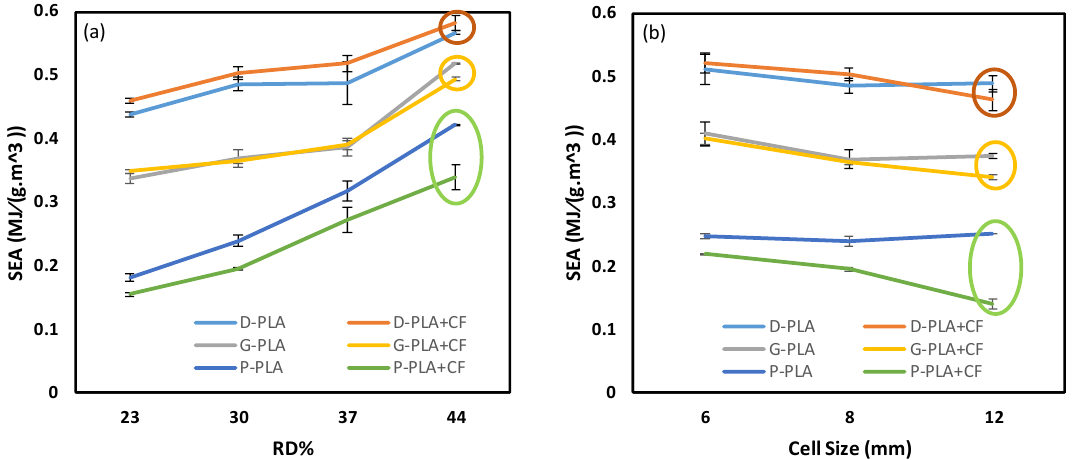
Figure 16. Specific energy absorption per volume of the Diamond, Gyroid, and Primitive structures at different: ( a ) unit cell sizes and ( b ) designed relative densities. Circles highlight the evident influence of the CF on the SEA at high RDs and larger cell size.